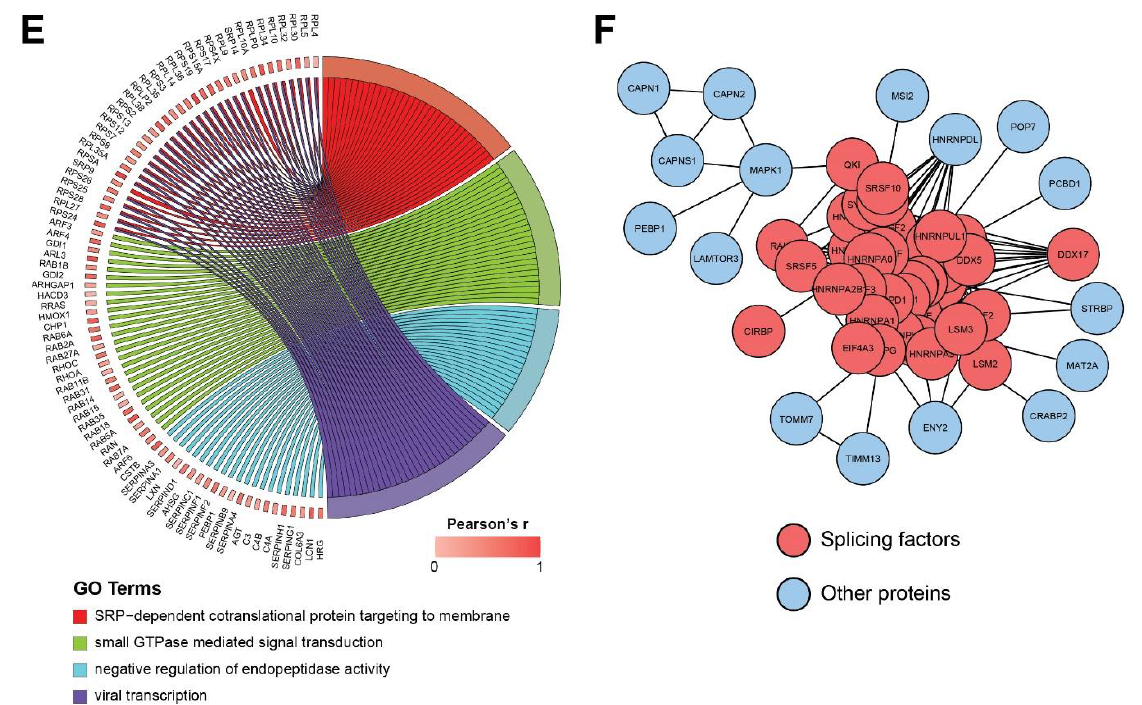
Figure 5. Heatmaps depicting correlation matrix of Pearson’s correlation coefficient calculated between the splicing factors in ( A ) Cluster 2 or ( B ) Cluster 3 and all the other proteins in the dataset that are not part of the spliceosome complex. Heatmaps are split into four clusters based on k-means partitioning. ( C ) Venn diagrams depicting the overlap between the positively and negatively correlated proteins in Cluster 2 and 3 respectively, and vice versa. ( D ) Plot of overrepresentation analysis results showing ontologies which are positively correlated with the splicing factors in Cluster 3 (FDR < 0.1). ( E ) Chord plot depicting all positively correlated proteins identified by overrepresentation analysis in Figure 5D. ( F ) Protein-protein interaction network showing interactions between splicing factors in Cluster 3 and positively correlated proteins. Only the closest protein interactors of splicing factors after MCL clustering are